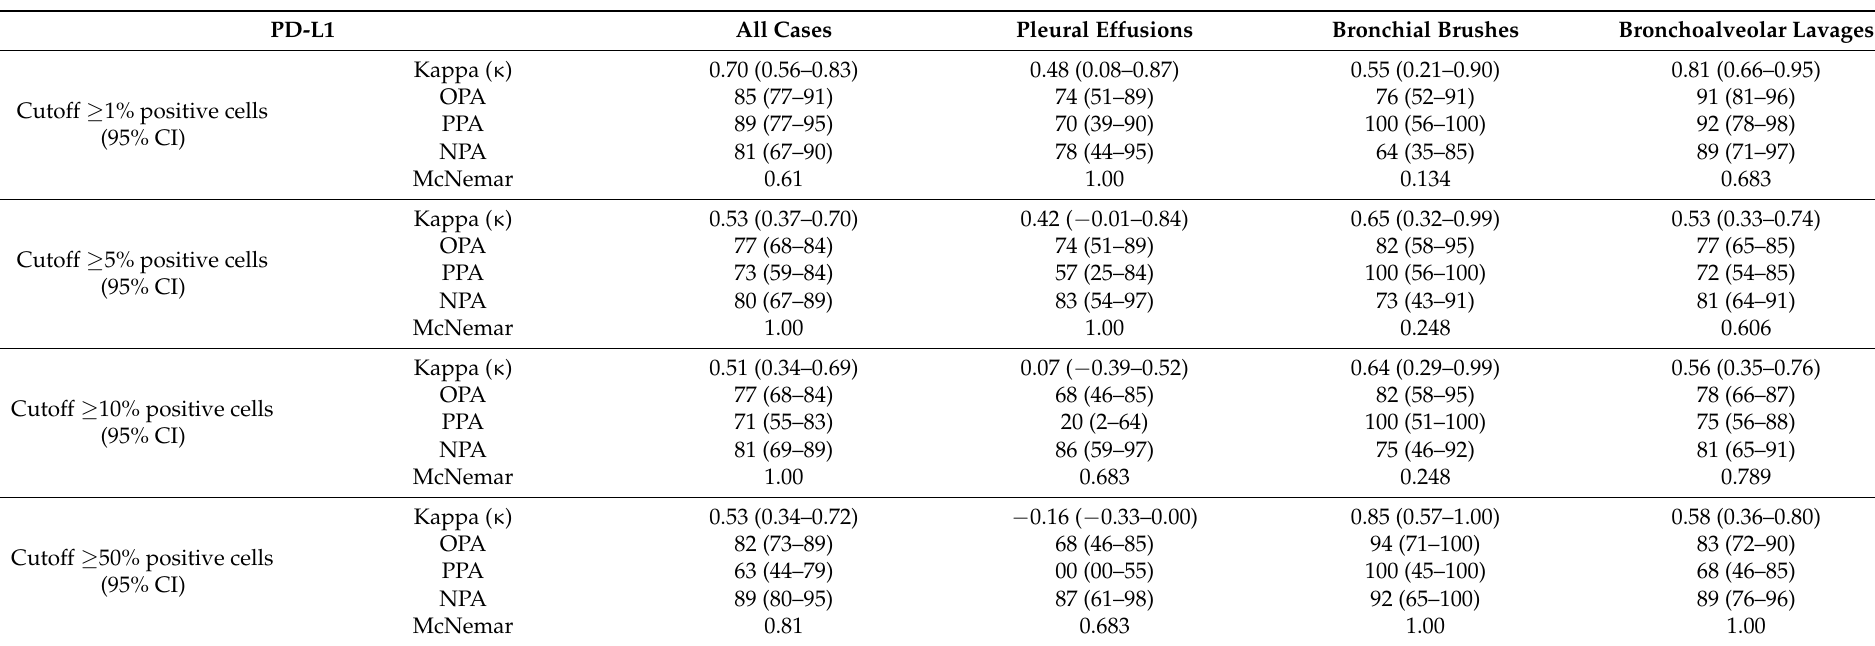
Table 2. Agreement of PD-L1 expression in paired histological and cytological non-small cell lung cancer specimens with different cytological sample types